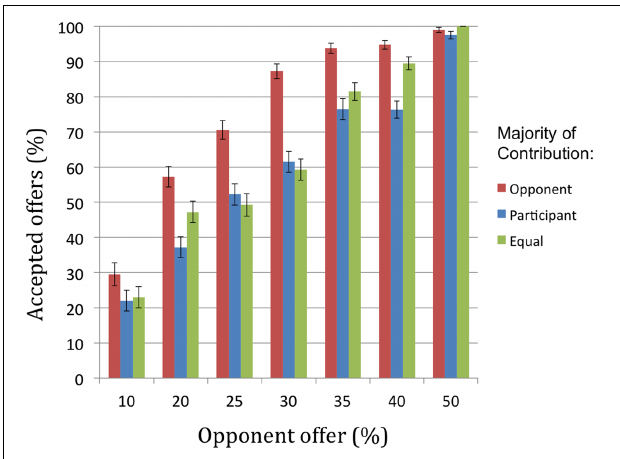
FIGURE 4 | Percentage of offers proposed by participants, ranging from equal (50%) to very unequal (20%), for each contribution condition.